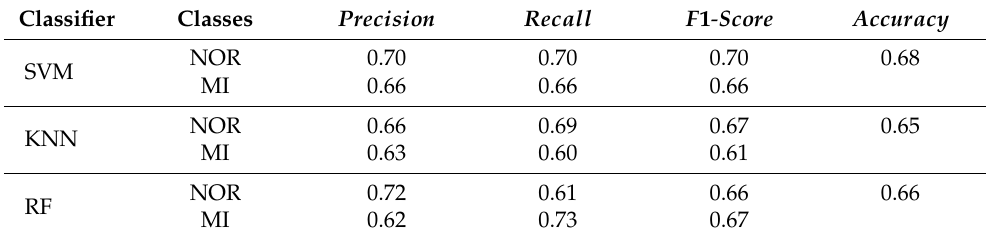
Figure 5. Illustration of different ECG signals after adding noises: ( a , b ) added electrode motion noise with SNR = 16 dB, ( c , d ) added baseline wander noise with SNR = 8 dB, ( e , f ) added muscle artifact noise with SNR = 2 dB, ( g , h ) added muscle artifact noise with SNR = − 2 dB. Table 6. Prediction performance